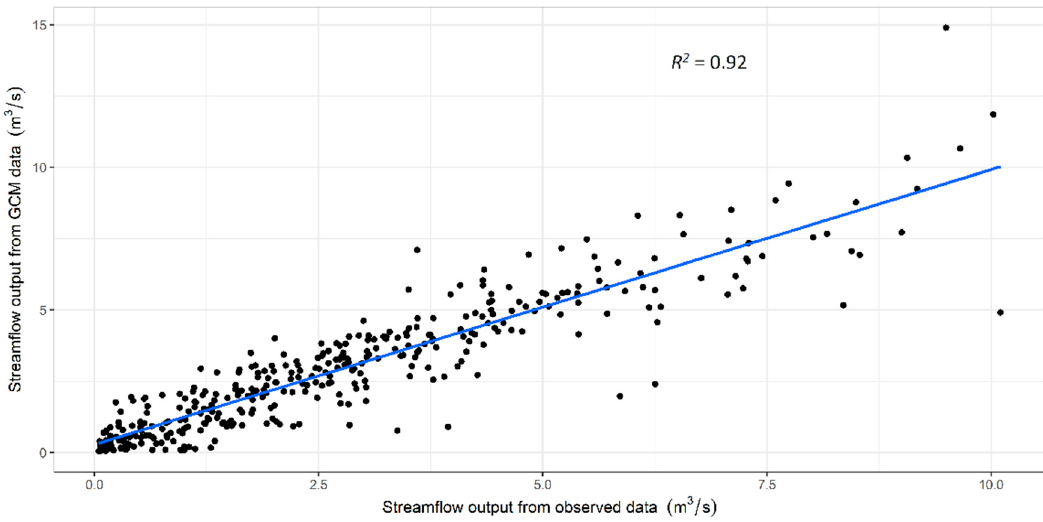
Figure A2. Comparison between streamflow simulated by GCM historical data and the observed climate data (Morgantown Municipal Airport) from 1950–1980 at monthly scale.